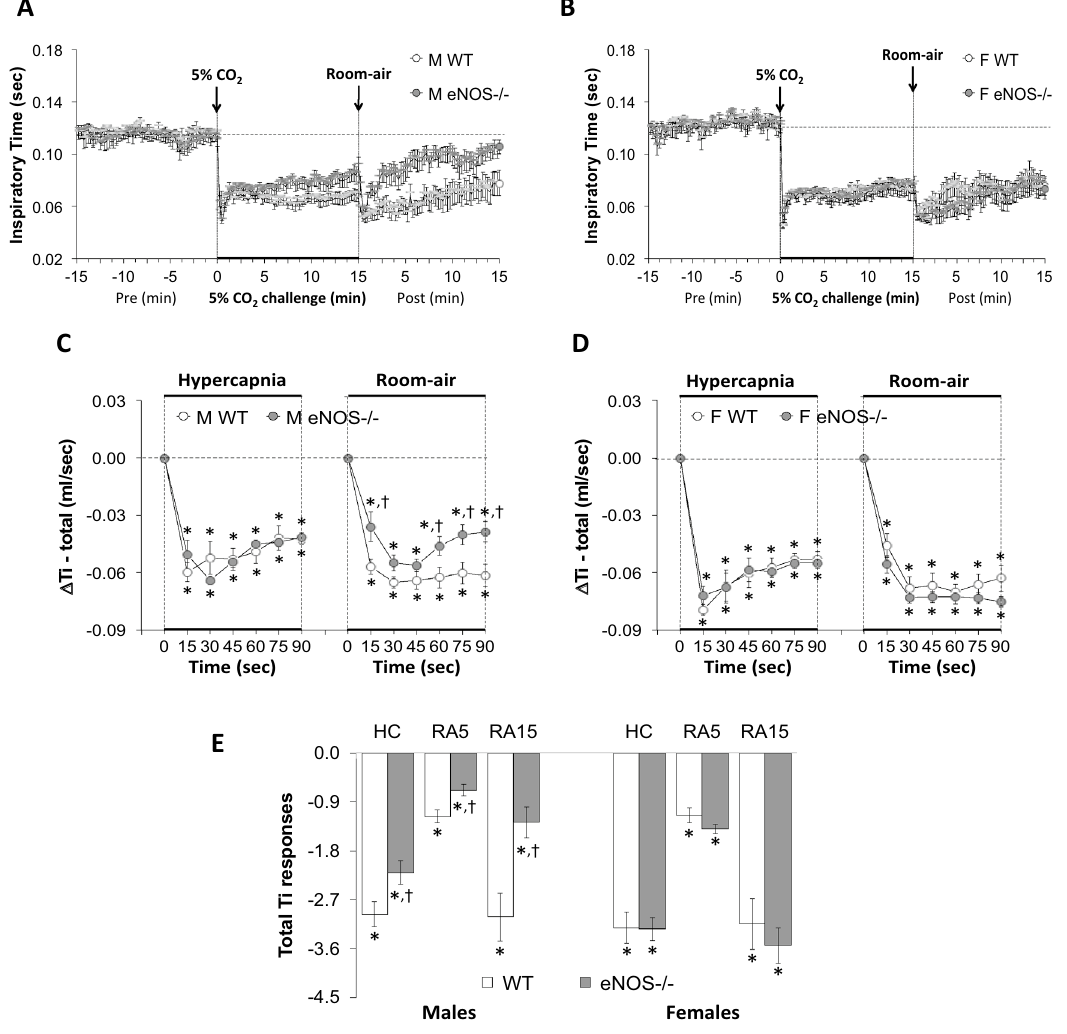
Figure 4. Panels ( A ) and ( B ) Inspiratory time (Ti) values before, during a hypercapnic (HC) gas challenge (5% CO 2 , 21% O 2 , 74% N 2 ) and upon return to room-air in male (M) and female (F) wild-type (WT) and eNOS knock-out (eNOS-/-) mice. Panels ( C ) and ( D ) Arithmetic changes in Ti in male and female WT and eNOS-/- mice during the first 90 s of exposure to the HC challenge and the first 90 s upon return to room-air. Panel ( E ) Total changes in Ti in male and female WT and eNOS-/- mice during HC challenge and during the first 5 min (RA5) and entire 15 min (RA15) return to room-air. The data are presented as mean ± SEM. * P < 0.05, significant change from pre-values. † P < 0.05, eNOS-/- versus WT within each